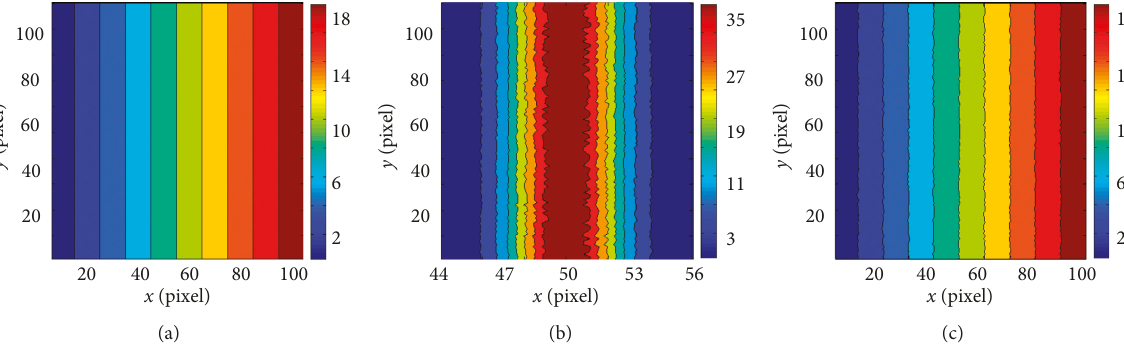
Figure 6: Uniform deformation field obtained different algorithms. (a) Deformation theory. (b) CTSFA. (c) SFA.